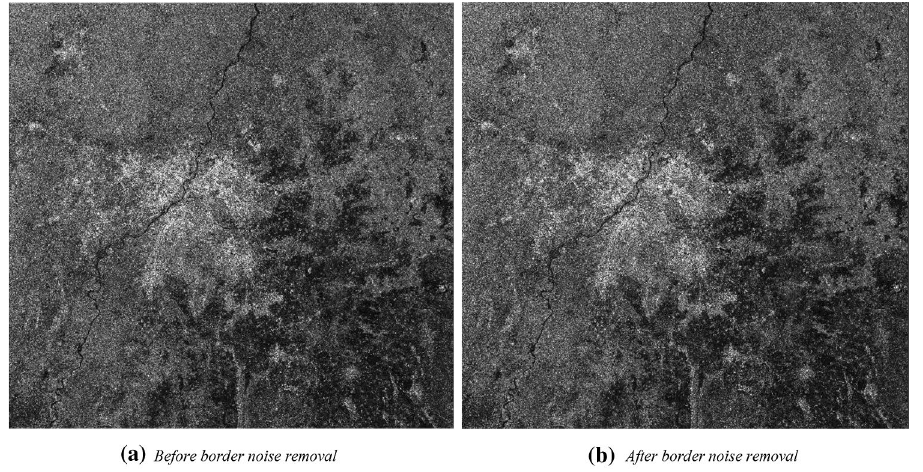
Figure 6. Effect of border noise removal in VH polarisation.